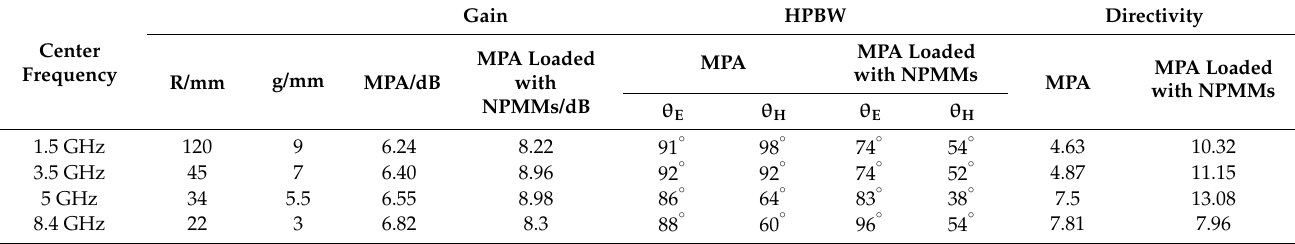
Table 1. Simulation of the different frequency bands MPAs loaded with linear-type